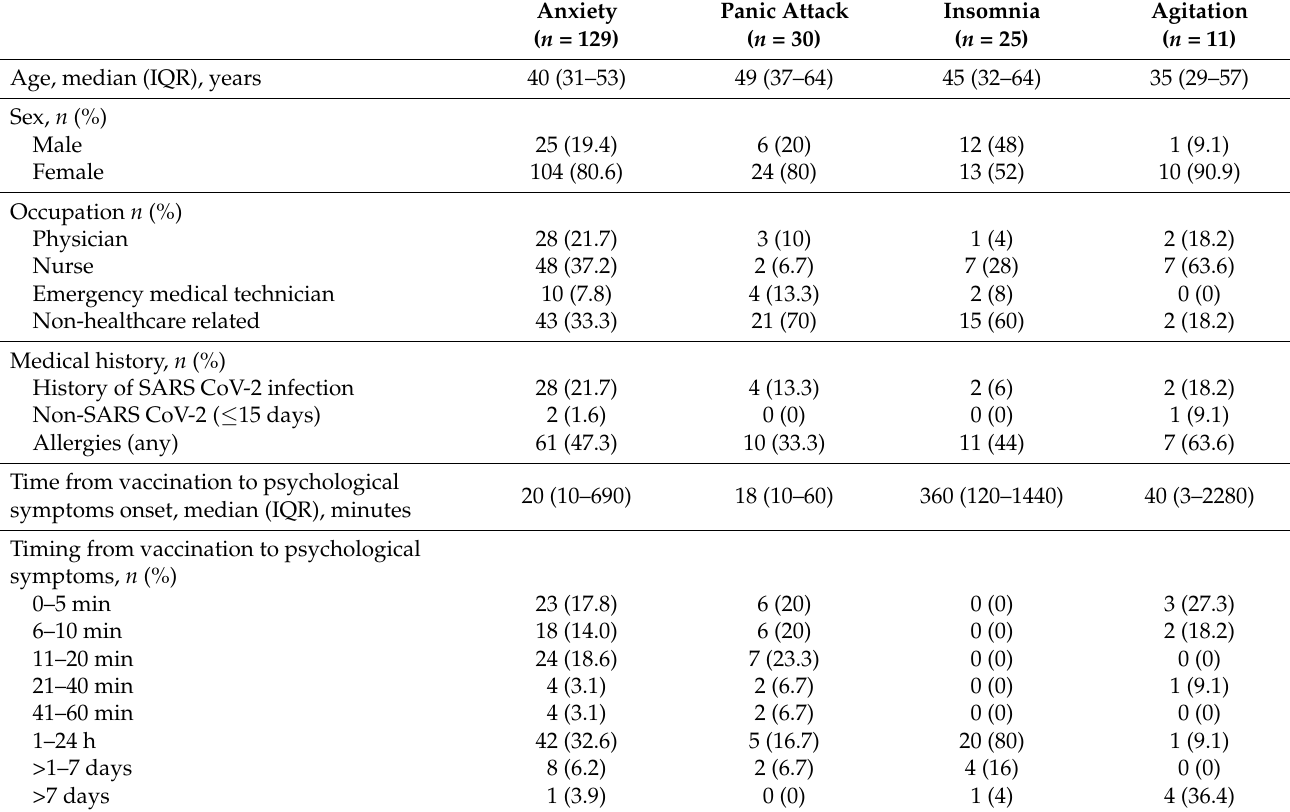
Table 3. Baseline characteristics of the